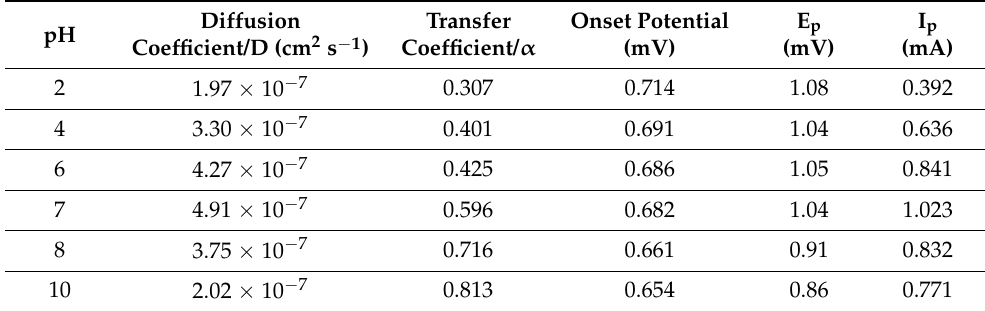
Figure 7. CVs of modified electrode GC/PANI/NiOnF at various sweep rate ranges (20 to 200 mV s − 1 ) in 0.5 mM nitrite solution and 0.1 M PBS at different pH ranges ( a ). pH 2, ( b ). pH 4, ( c ). pH 6, ( d ). pH 7, ( e ). pH 8, and ( f ). pH 10). ( g ) The relation between the square root of sweep rate and nitrite’s oxidation current. ( h ) The relation between the Log of sweep rate versus nitrite’s oxidation potential. Table 1. Representation of Diffusion coefficient, Transfer coefficient, Onset potential, Ep, and Ip for modified GC/PANI/NiOnF for different pH